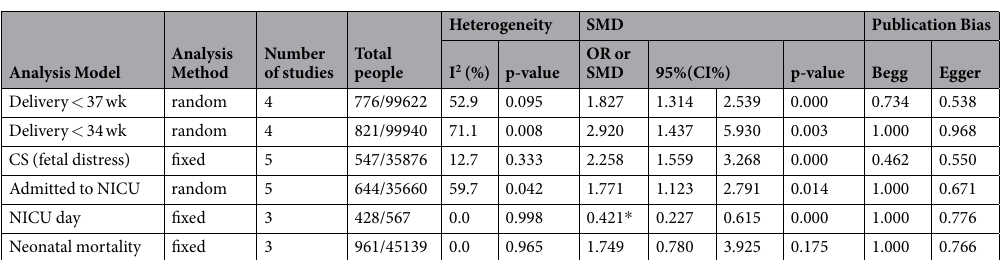
Table 4. Meta-analysis for adverse neonate outcome between isolated SUA and normal umbilical artery. * Indicates SMD. Delivery < 37 wk: neonates born when the gestational age was shorter than 37 weeks. NICU: neonatal intensive care unit. CS: Cesarean